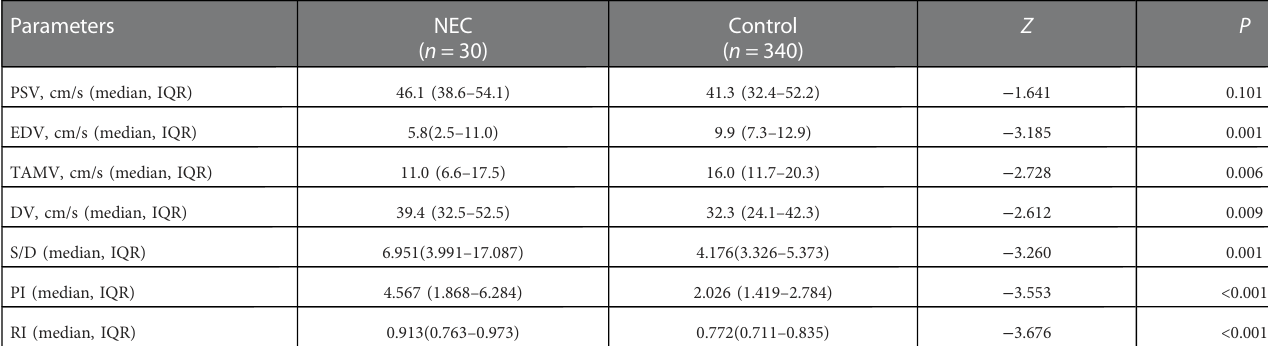
TABLE 2 SMA Doppler ultrasound